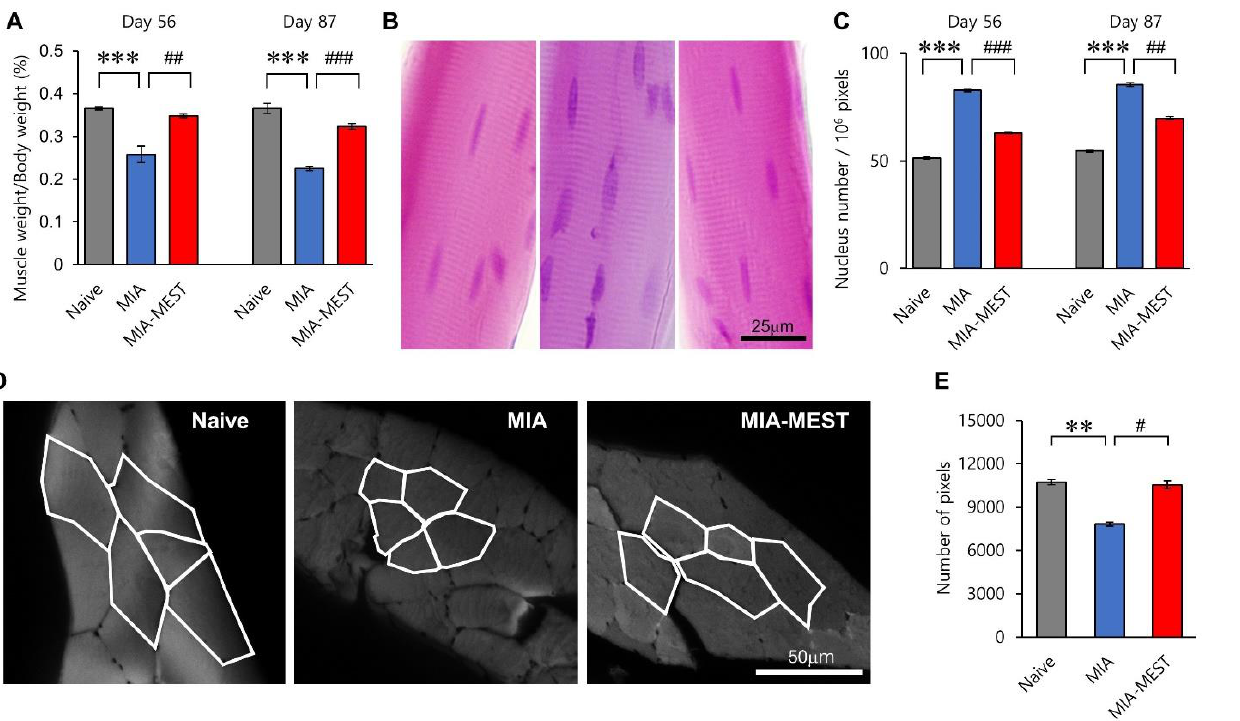
Figure 3. MEST alleviates MIA-induced muscle atrophy. The ratio of RFM weight to body weight on days 56 and 87 (n = 3) ( A ). Nucleus number in longitudinal section of RFM at days 56 and 87 (n = 3, total 72 slices per group) ( B , C ). The cross-sectional area of muscle fibers in transverse section of RFM at day 87 (n = 3, total 45 cells per group) ( D , E ). Representative images on day 87 ( B , D ). White lines in D indicate the selected muscle fibers for data analysis. ** p < 0.01, *** p < 0.001. # p < 0.05, ## p < 0.01, ### p < 0.001. Data are presented as mean ± 95% confidence intervals.